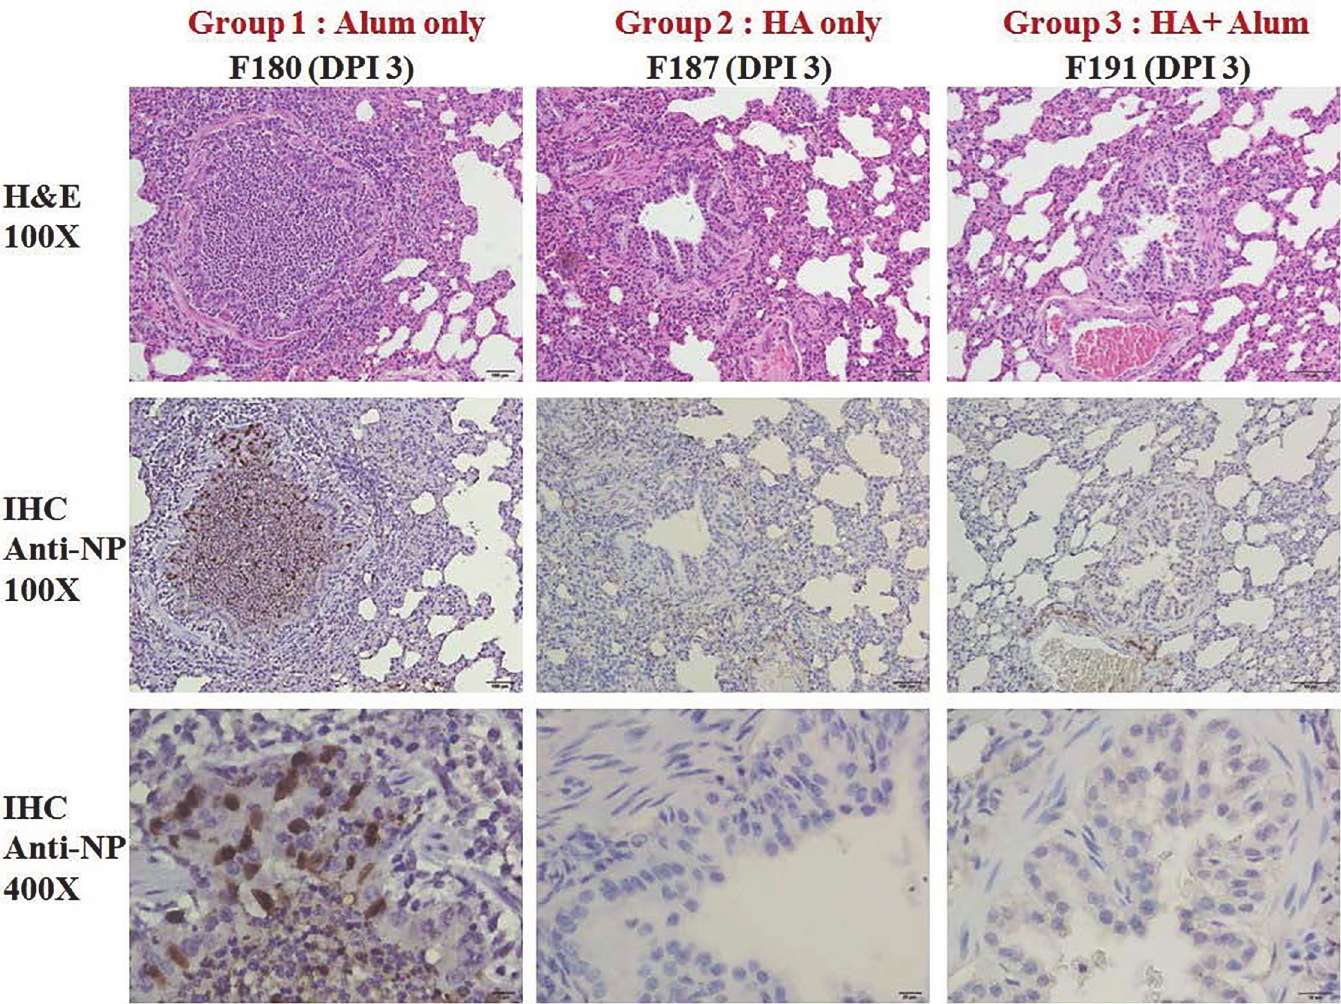
Fig 3. Histopathological examination and immunohistochemical (IHC) staining in lung tissues of ferrets at 3 days post challenge (DPC) with wild- type influenza H7N9 viruses. Top panel is H&E staining with 100-fold magnification (100×), middle panel is IHC staining with 100×, and bottom panel is IHC staining with 400×. Tissue with brown color indicates viral antigen detected by a mouse anti-NP monoclonal antibody in IHC staining.